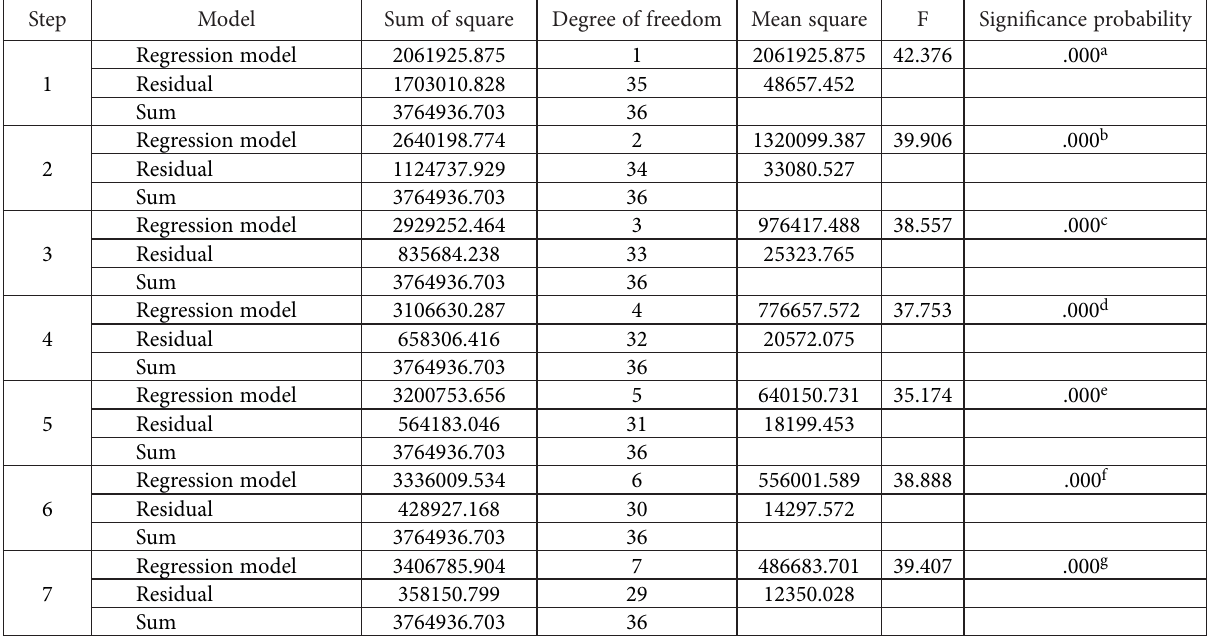
Table 11. Multiple linear regression analysis using the stepwise selection method – variance analysis